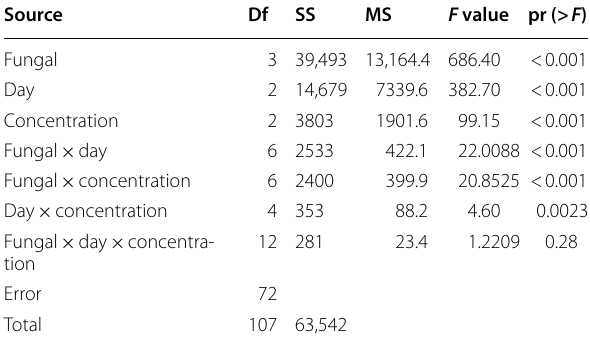
Table 2 Factorial Analysis of Variance of the virulence of two isolates of Isaria javanica and one isolate of Purpureocillium lilacinum against the second instar of Bemisia tabaci